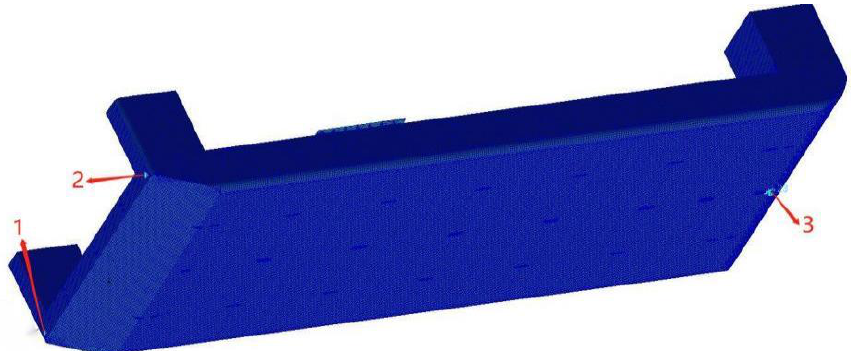
Figure 13. Model boundary conditions.